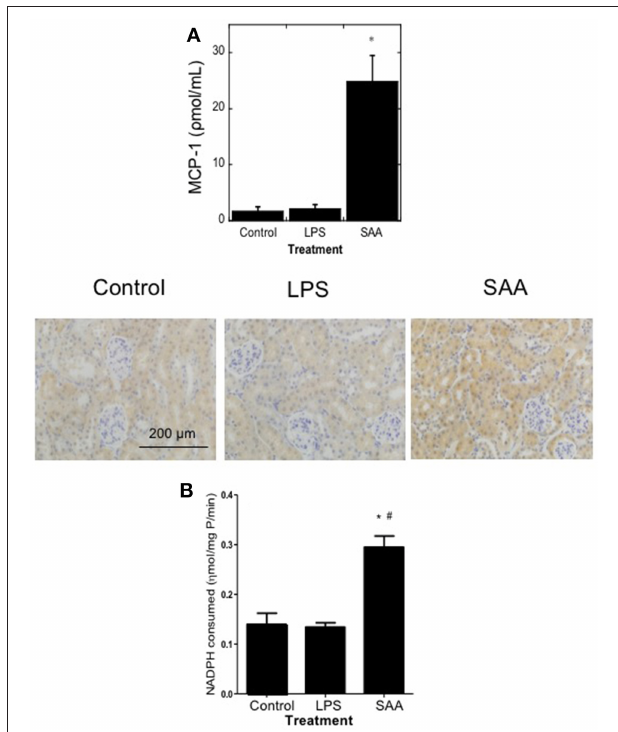
FIGURE 1 | Plasma MCP-1 and renal antioxidant Gpx-1 protein and activity are elevated in mice treated with SAA. ApoE − / − mice were administered SAA, LPS or sterile PBS (vehicle control) by i.p. injection every 3 days over 2 weeks (as described in Study 1). Plasma was isolated 4 weeks after commencement of SAA treatment and levels of (A) MCP-1 by commercial ELISA. Data represent mean ± SD, n = 8 (control and LPS groups), or 10 (SAA group) animals. * Different to vehicle-control and LPS-treated mice in the absence of SAA; P < 0.05. Renal sections were then stained with anti-GPx1 antibody in batches so that all reagents and handling were identical, as described in Methods. Immuno-reactivity of representative kidney sections from control, LPS, and SAA-treated mice are shown. Figures represent at least two independent samples from each treatment group; magnification, x 200; scale bar, 200 µ m. Renal homogenates were tested for total GPx activity (B) . Data expressed as means ± SD for control ( n = 5), LPS ( n = 8), or SAA ( n = 4) treatments. *Different to the vehicle-control group; P < 0.05; # Different to the LPS group; P <